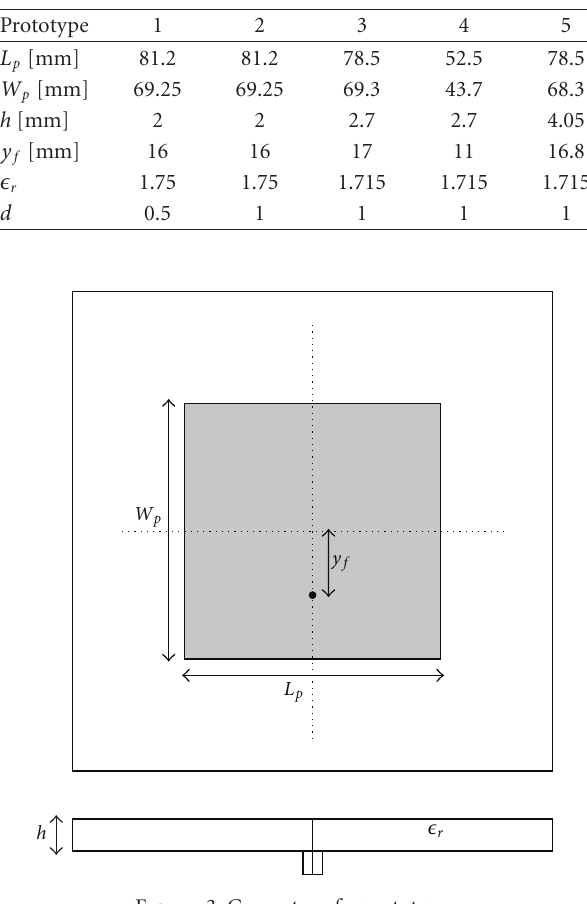
Figure 3: Geometry of a prototype.